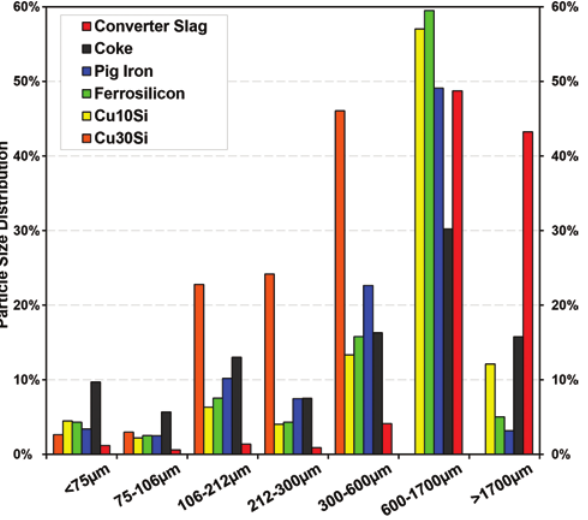
Fig. 1: Particle size distribution of the converter slag and reductants used in tests.